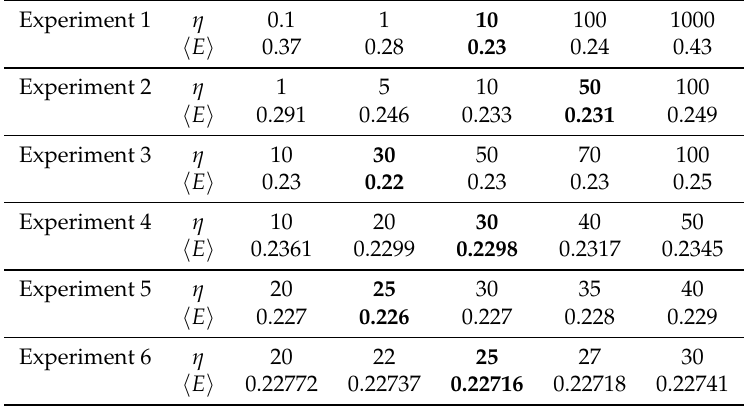
Table A2. Results of the experiments to identify the almost optimum value of η giving the smallest (cid:104) E (cid:105) when Correlation is Ignored (CI).